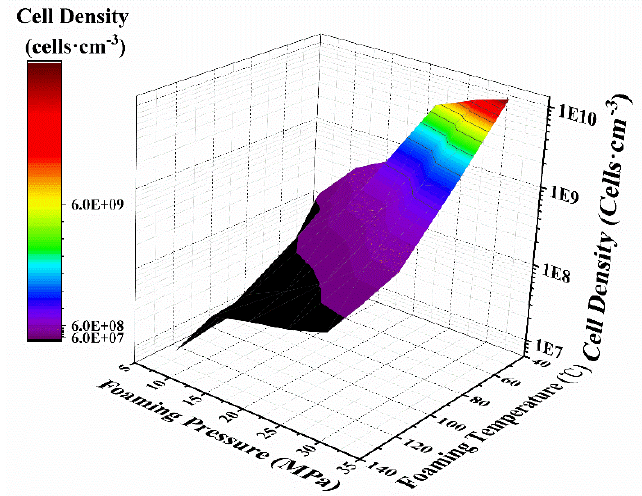
Figure 3. Cell size of the foamed samples as a function of the foaming parameters.